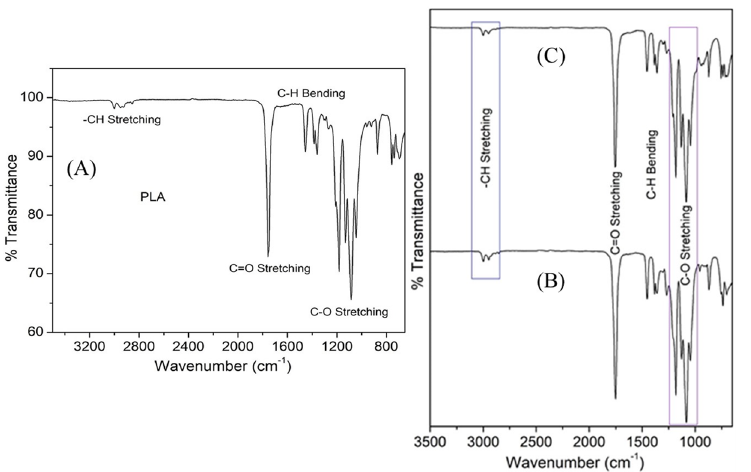
Figure 4. FT-IR spectra of commercially purchased PLA ( A ), PLA/HAp ( B ), and PLA/Wollastonite ( C ) composite.